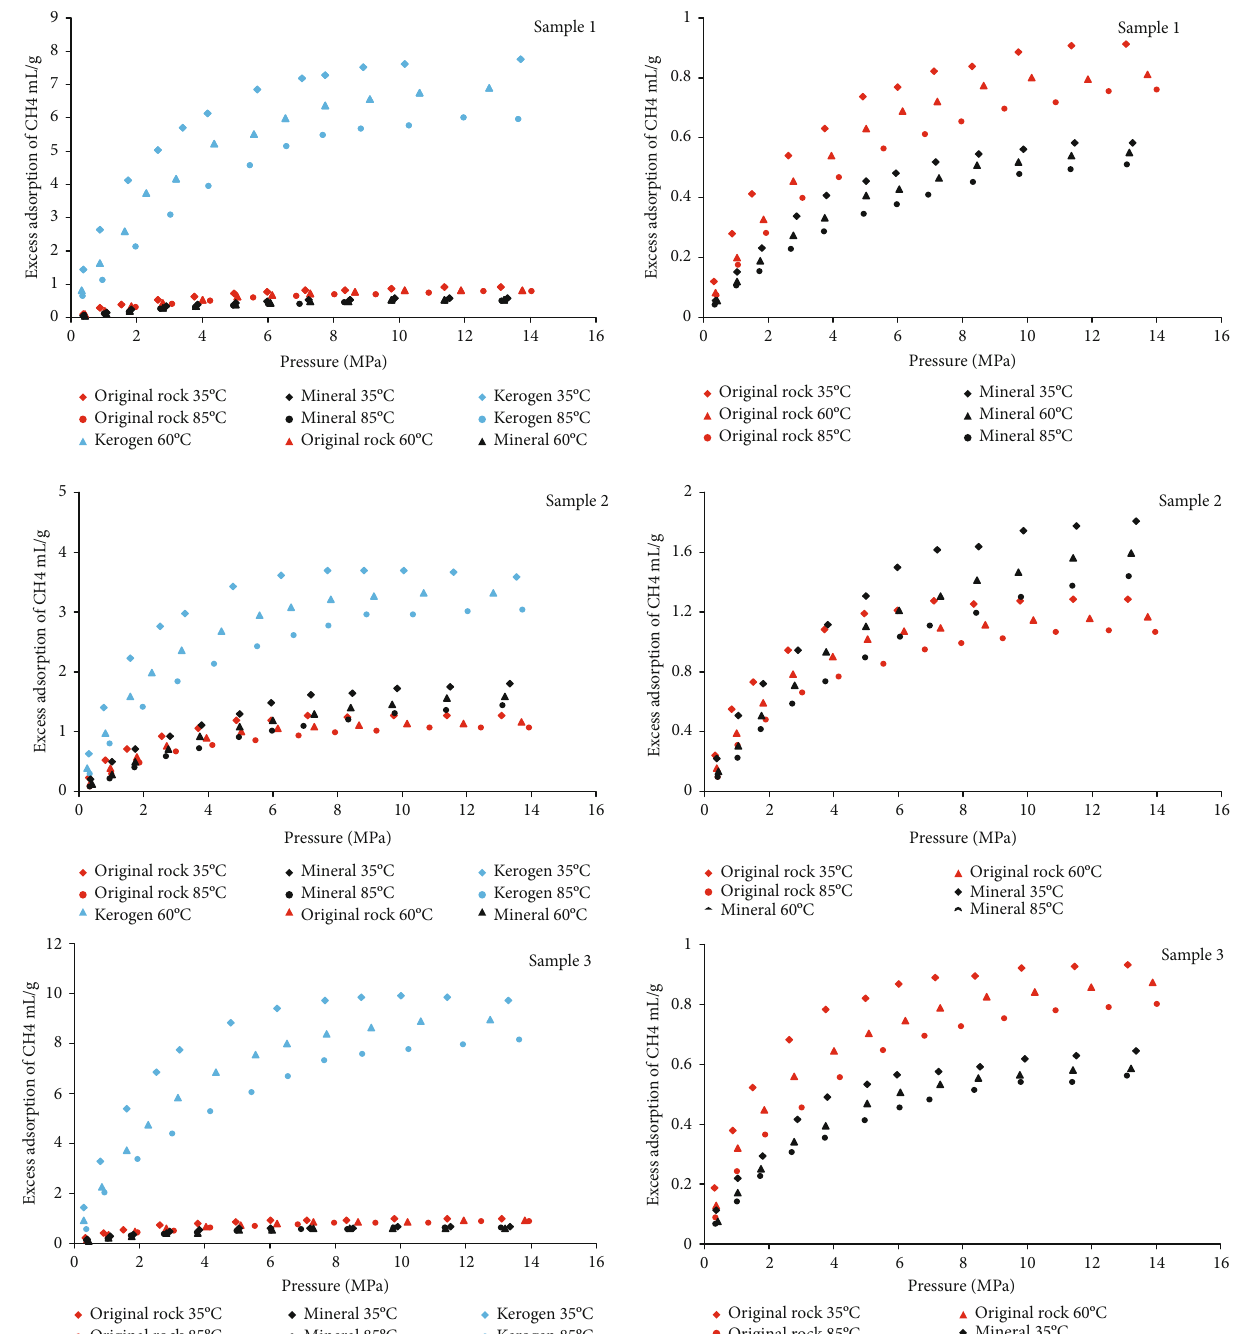
Figure 2: Excess methane adsorption capacity of each sample obtained from the